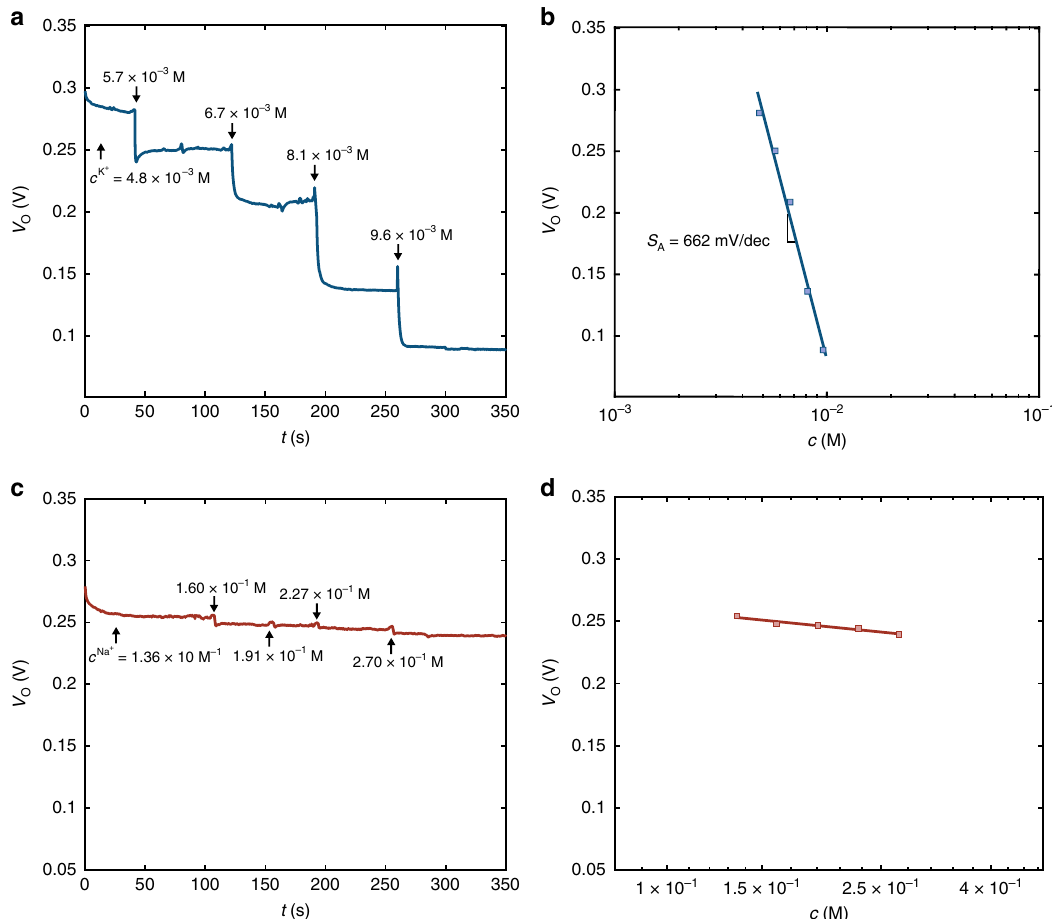
Fig. 7 Selective K + sensing in human blood serum. a Real time high sensitivity K + detection in human blood serum. The K + concentration range is 4.8 10 − 3 M – 9.6 10 − 3 M. The potassium concentration of the blood serum is increased over time by spiking small amounts of 1 10 − 1 M KCl water solution. The measurements are performed at V I = 0.37 V. b Measured steady-state output voltage V O (symbols) as a function of K + concentration c . Full blue line is the linear least square fi t to the measurements and yields a sensitivity S A = 662 mV dec − 1 . c Control experiment demonstrating the selectivity against sodium in blood serum. V O is measured over time and the Na + concentration of the blood serum is systematically increased from 1.36 10 − 1 M to 2.70 10 − 1 M. The K + concentration is constant and amounts to 4.8 10 − 3 M. f Measured (symbols) steady state V O as a function of c Na + . Solid line is the linear least square fi t to the measurements and yields a cross-sensitivity equal to 44 mV dec − 1 , which is more than 15-fold lower than the sensitivity of the selected K +